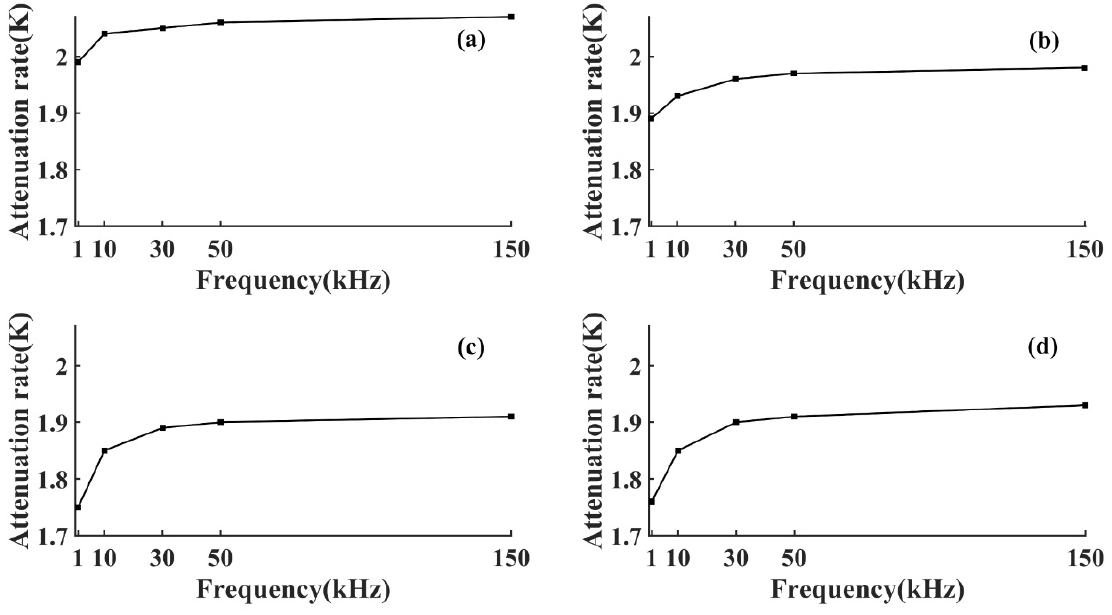
Figure 10. Attenuation coefficient K. ( a ) T1 specimen; ( b ) T2 specimen; ( c ) T3 specimen; ( d ) T4 spec- imen.